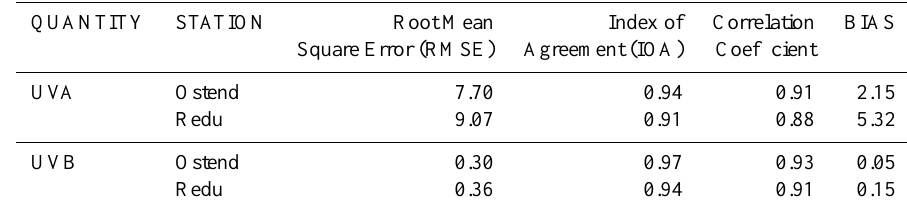
Table 2. Error Statistics between estimated surface level UV irradiance and measurements.